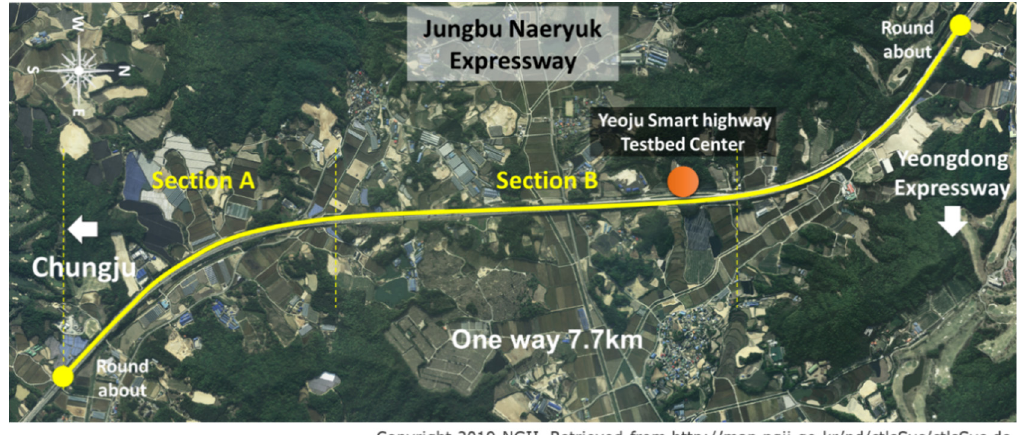
Figure 22. Yeoju Smart Highway testbed.